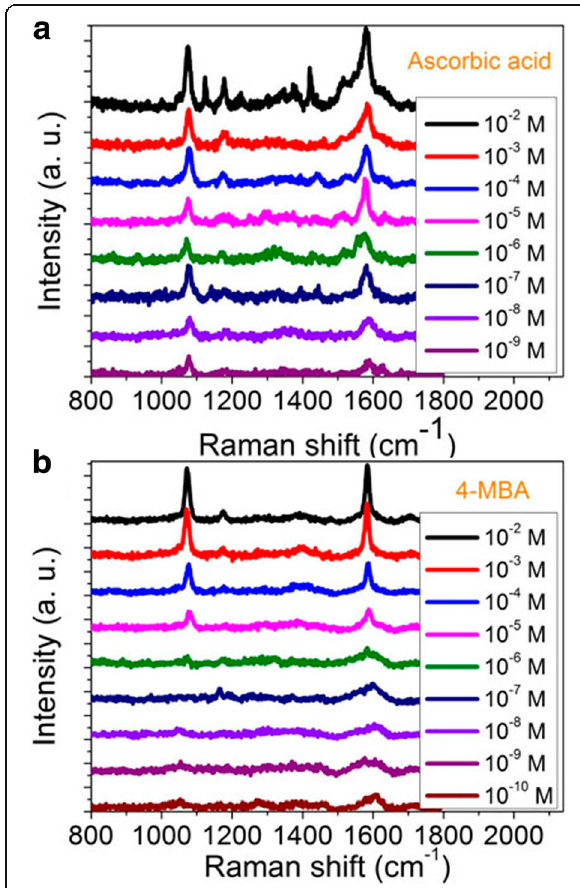
Fig. 13 Raman spectra of a ascorbic acid molecules with the concentration changing from 10 − 2 to 10 − 9 M and b 4-MBA with the concentration changing form 10 − 2 to 10 − 10 M in the dual-layer porous Au films. The sputtering time of each layer of porous Au films is 47 s. Laser power: 0.24